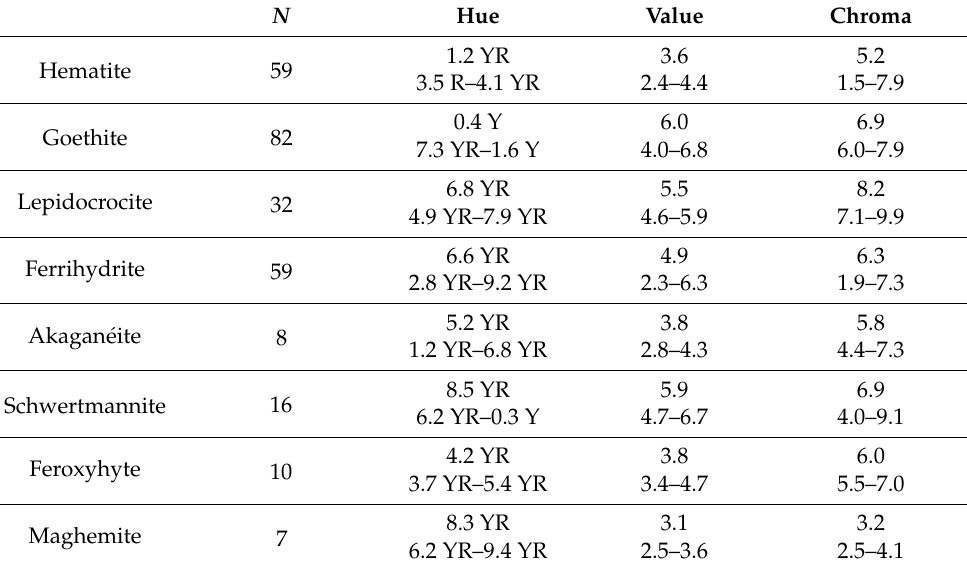
Table 1. Munsell colors of the Fe oxides (median and range) (Reprinted with permission from Ref. [34]. 1999, John Wiley and